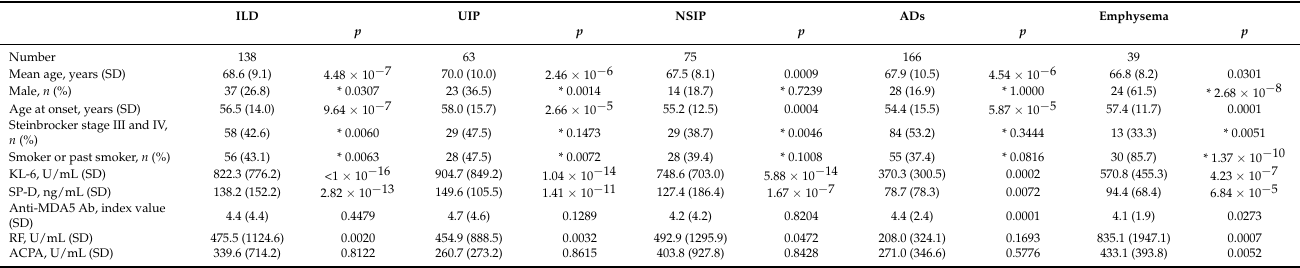
Table 1. Characteristics and anti-MDA5 Ab of RA